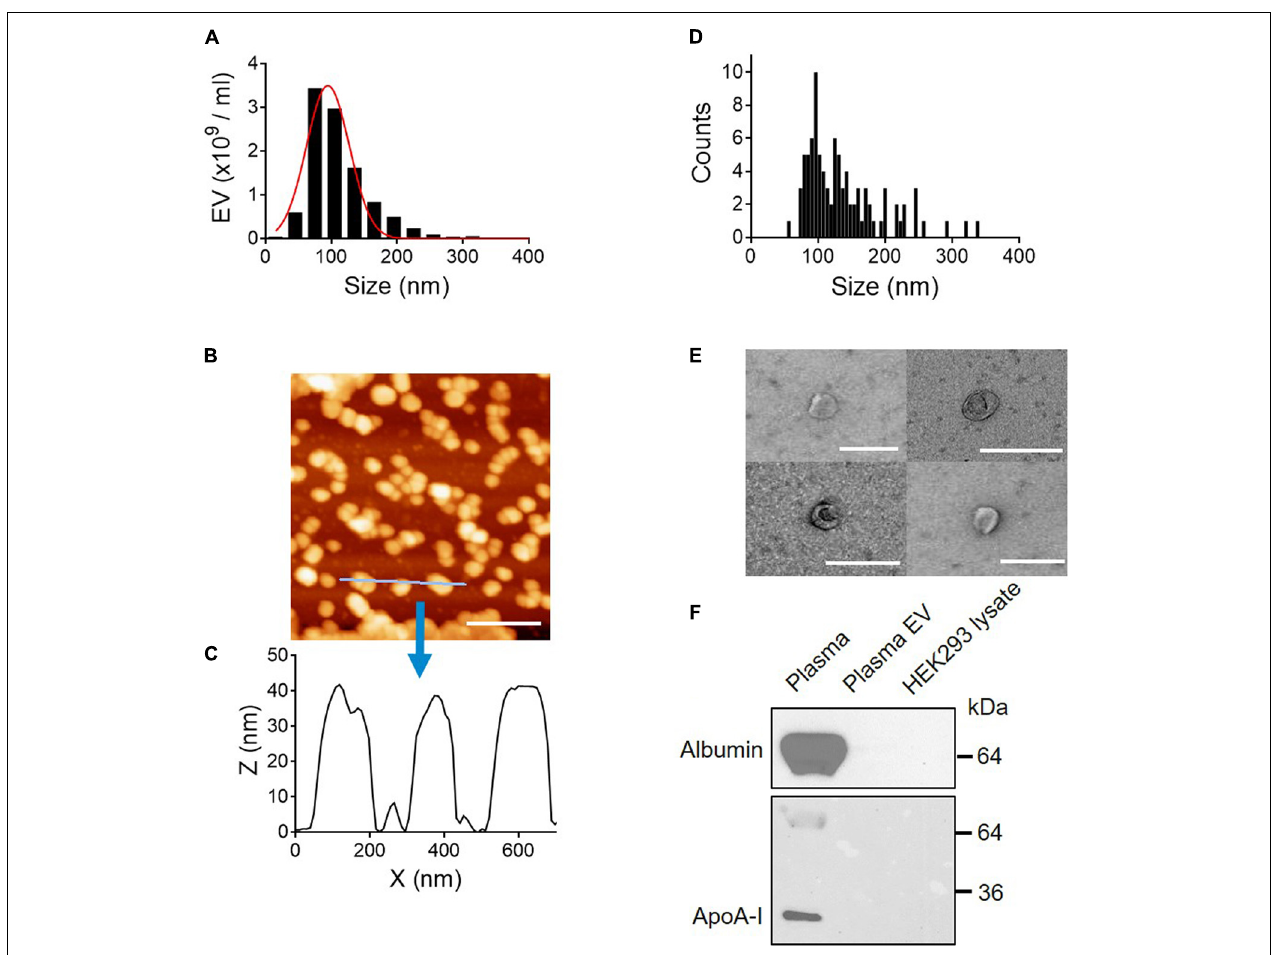
FIGURE 2 | Physical and biochemical characterization of EVs isolated from plasma. (A) Size distribution of plasma EVs determined by NTA. Median diameter (nm), 90.2 ± 4.58 SD. (B) AFM image (scale bar, 400 nm) and (C) line scan profiles of isolated EVs. (D) Size distribution of plasma EVs determined by AFM. (E) Negative-stain TEM images of EVs. Scale bar, 200 nm. (F) Purity of EV samples tested by Western blot. Plasma proteins, albumin, and ApoA-I are removed from plasma EV samples. Seven micrograms of protein from whole plasma, plasma EVs isolated using SEC, and HEK293 cell lysate were subject to SDS–PAGE and immunoblotted with antibodies against albumin and